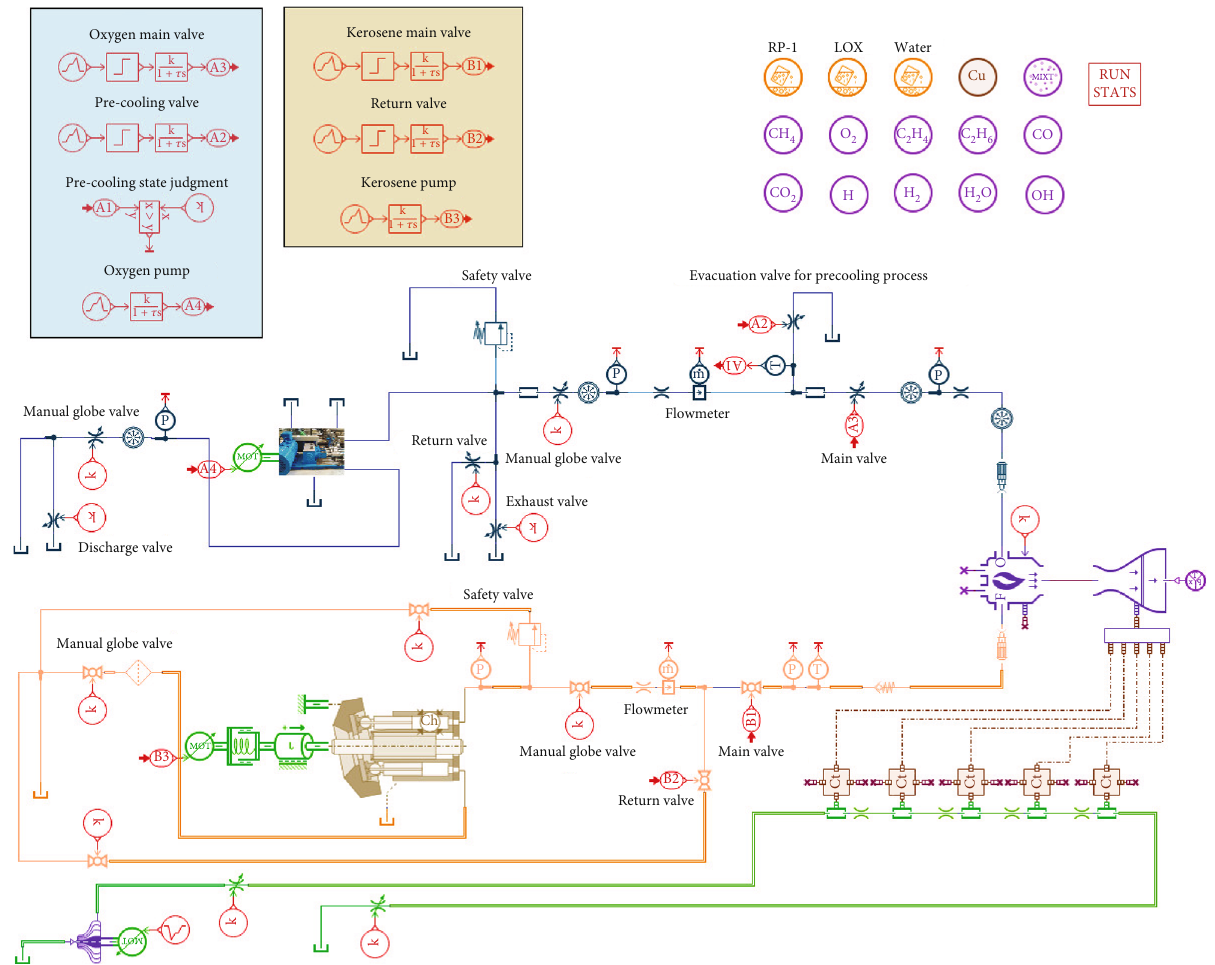
Figure 5: The structure diagram of the LRE test system. Table 4: Parameters of the main pipelines. Table 5: Measured performance parameters of